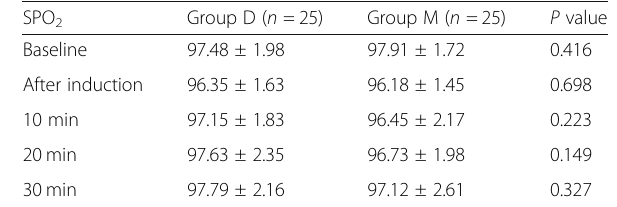
Table 4 Comparison of MAP (mmHg) in the studied groups (data are presented as mean ± SD)